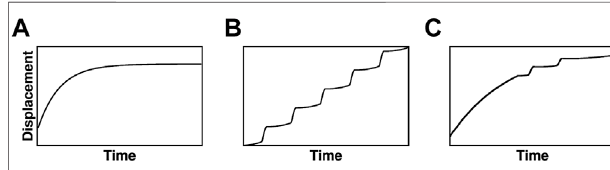
FIGURE 1 | Schematic in fl ation regimes observed at volcanoes and mentionedwithinthetext. (A) In fl ationwithamonotonicallydecayingrateoften explained by the linear dynamics of pressure build-up within a storage zone through magma supply (e.g., Pinel et al., 2010). (B) Regime of successive transient in fl ation episodes superimposed onto an in fl ation with constantrate;thisregimeisreferred toas “ episodicin fl ation events ” byJietal. (2017) and it is observed for example at Akutan volcano. (C) Episodic in fl ation events superimposed onto a longer period in fl ation with decaying rate (e.g., Walwer et al.,